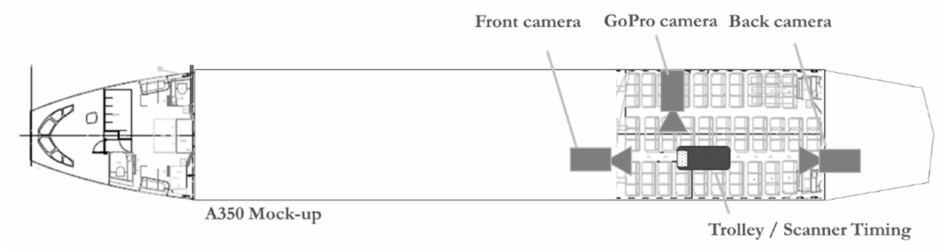
Figure 19. Validation recording